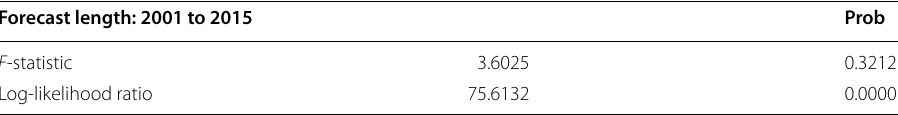
Table 7 Chow forecast